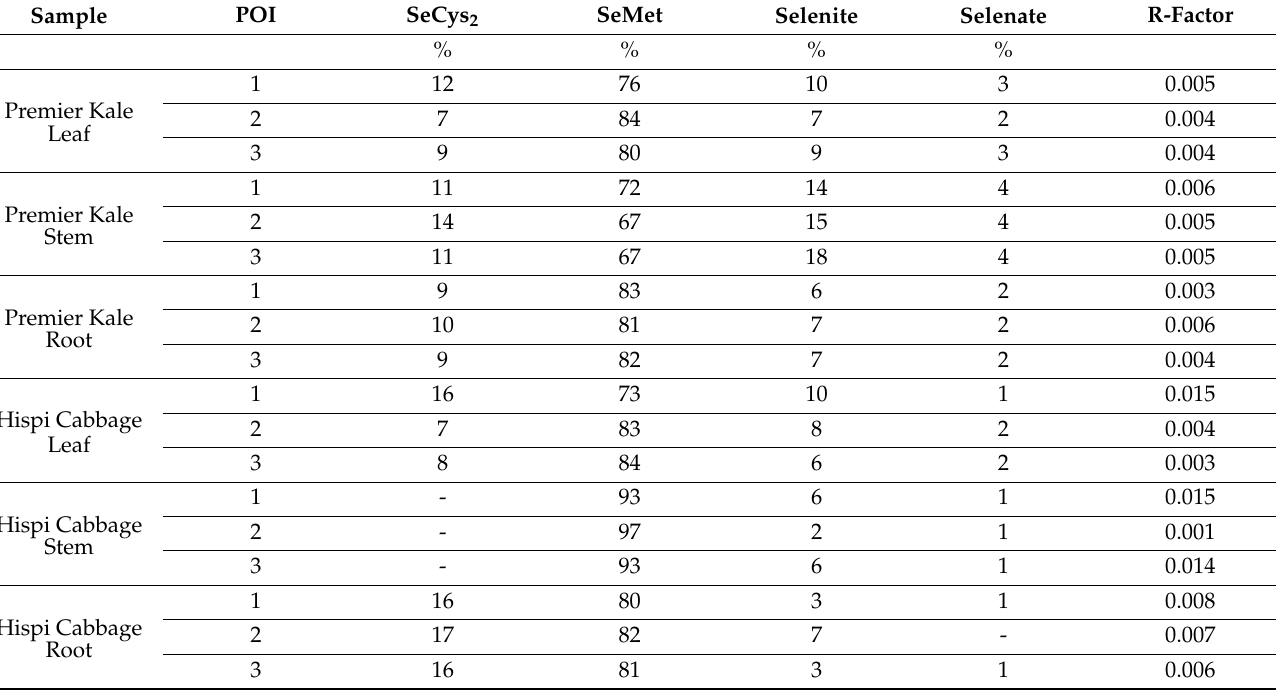
Table 7. Linear combination fits for selected Brassica oleracea (Se accumulator) species from site FF measured in ATHENA. The goodness of fit is determined by the R-factor. The improvement in the fit for the selenate values <4% was